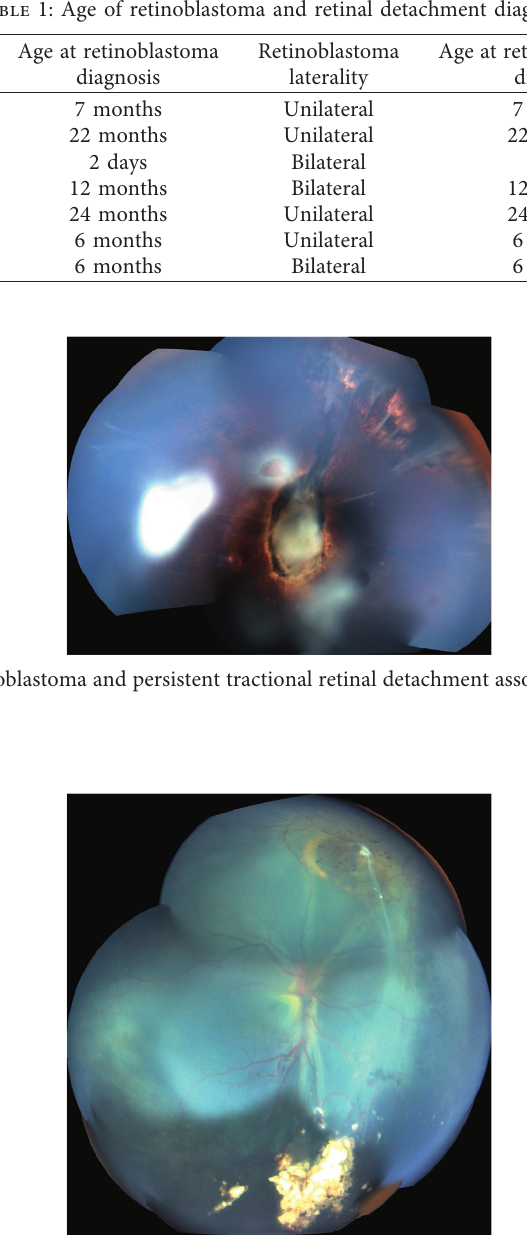
Figure 3: Patient 5 with treated retinoblastoma and persistent complex retinal detachment (tractional and exudative) of the right eye.